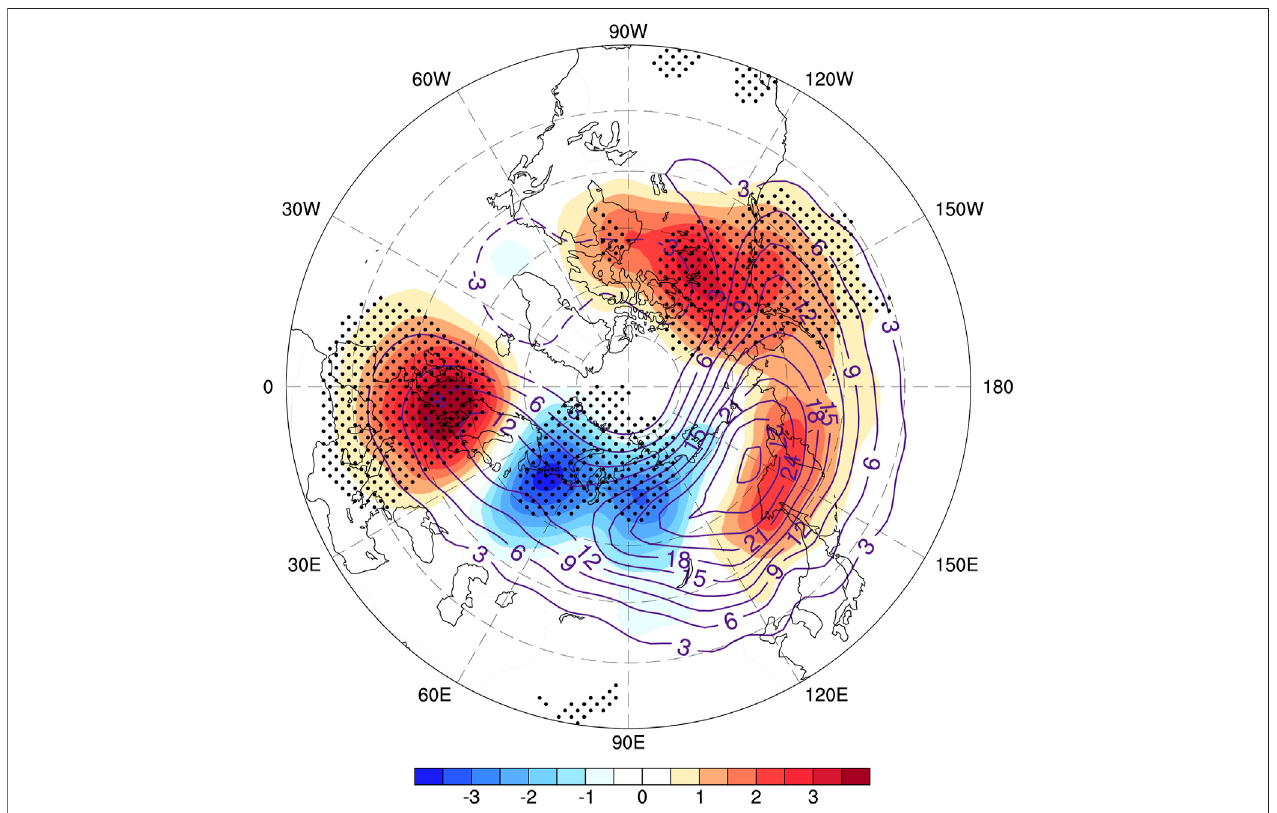
FIGURE 8 | Regression of January – February vertical WAF anomalies (shading; 10 − 3 m 2 s − 2 ) at 50 hPa against the negative October SNOWI during 1979 – 2017. Contours denote the climatological mean of 50 hPa vertical WAFs. Stippled regions indicate that the anomalies are signi fi cant at the 90% con fi dence level.